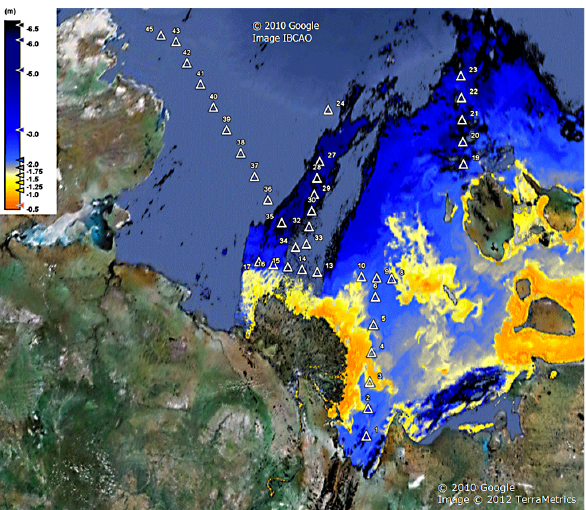
Figure 3. MERIS colour-coded map of C2R_Z90, the first atten- uation depth, 7 September 2010 at 10:48 a.m. (local time) with the land and detected clouds transparently masked. The transpar- ent masks display the Google Earth ™ land mosaic and the IBCAO bathymetry ( © 2010 Google, Image © 2012 TerraMetrics, Image IB- CAO) as background. Stations of the TRANSDRIFT-XVII ship ex- pedition in September 2010 are displayed as triangles.